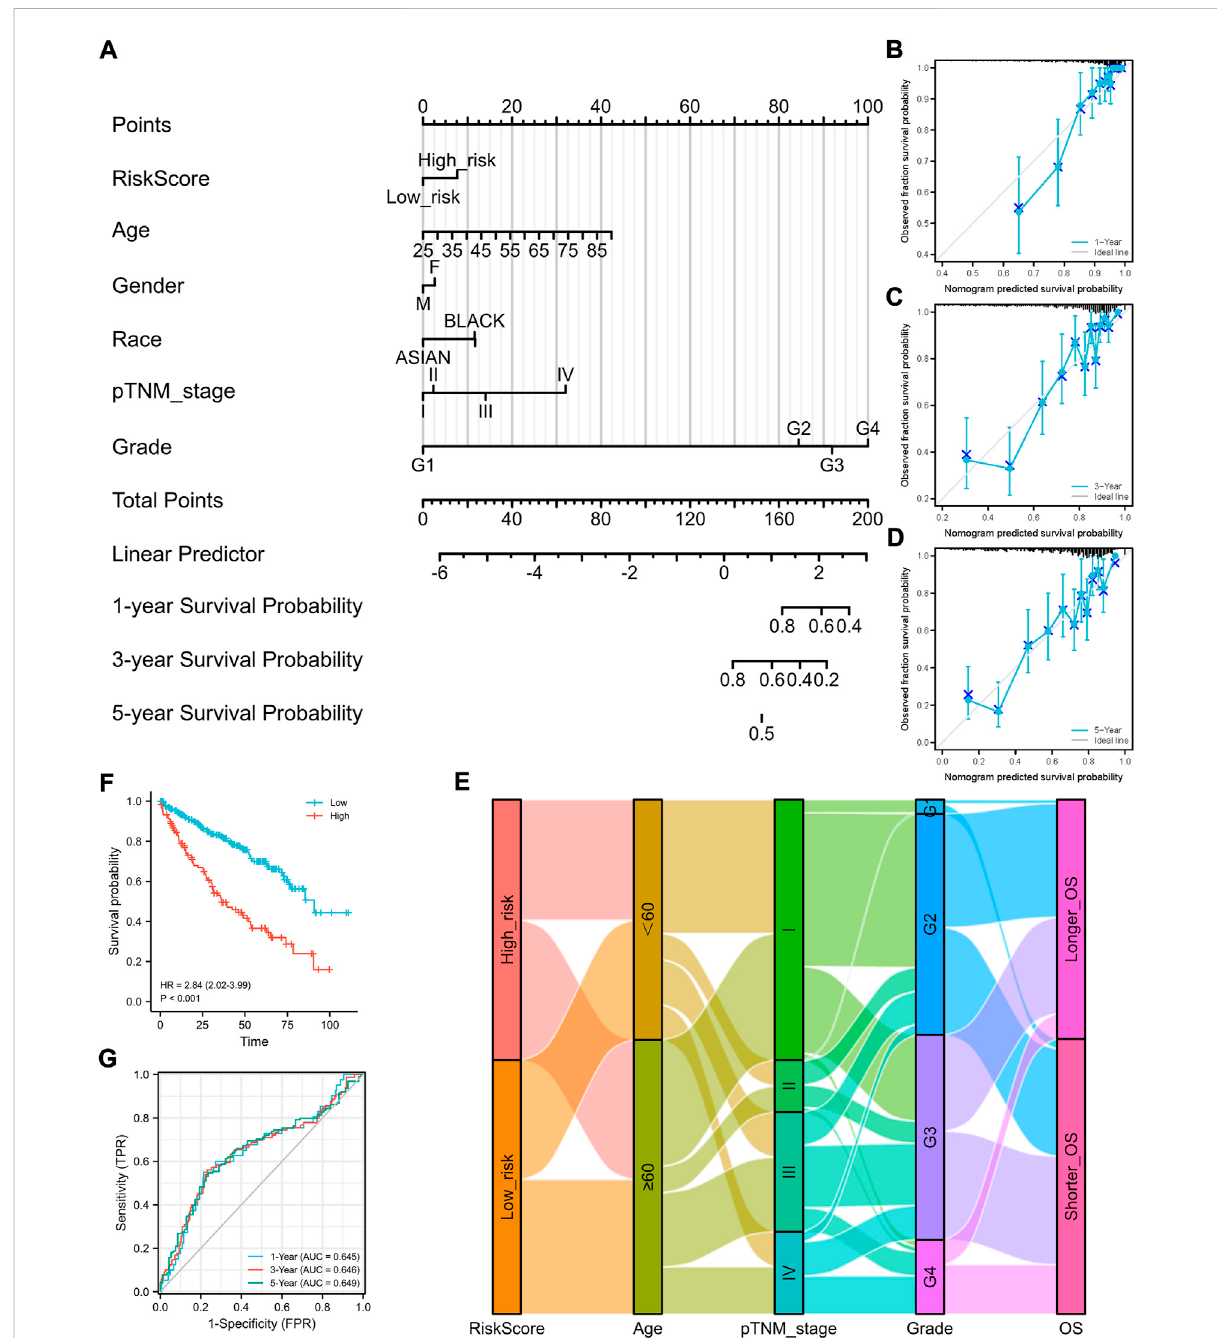
FIGURE 2 Construction of a nomogram and the independent signature validation. (A) Nomogram for predicting 1-, 3-, or 5-year OS rates in patients with ccRCC. (B) Calibration plots for predicting 1-year OS rate. (C) Calibration plots for predicting 3-year OS rate. (D) Calibration plots for predicting 5- year OS rate. (E) Sankey Diagram showing the association between signature risk scores and clinicopathological characteristics. (F) Validation of the signature in overall survival based on data from the cBioPortal online database. (G) ROC curves of the signature validation for overall survival rates at 1, 3, and 5 years. OS, overall survival; ROC, receiver operating